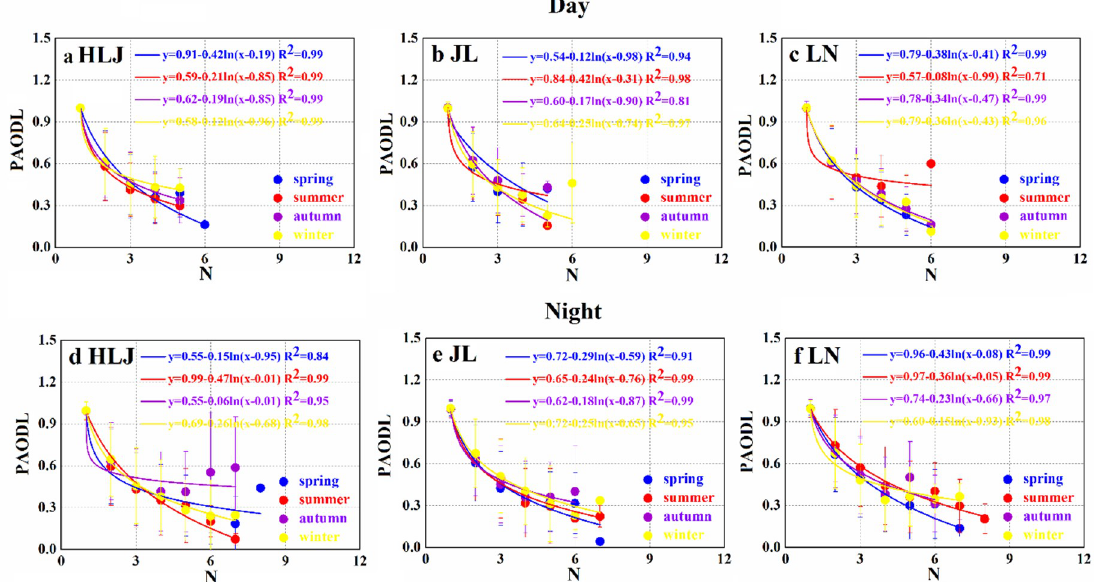
Figure 11. The correlation between TAH and N over NEC. Where, ( a , d ) represent HLJ, ( b , e ) represent JL, and ( c , f ) represent LN.